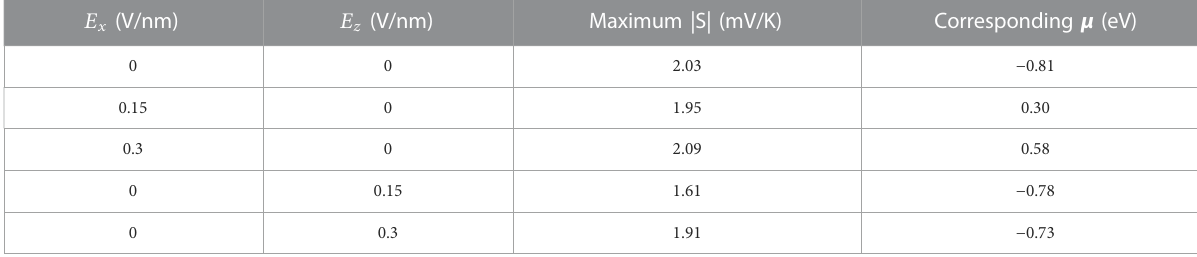
TABLE 1 Seebeck coef fi cient and corresponding chemical potential in the presence of different electric fi elds. E x